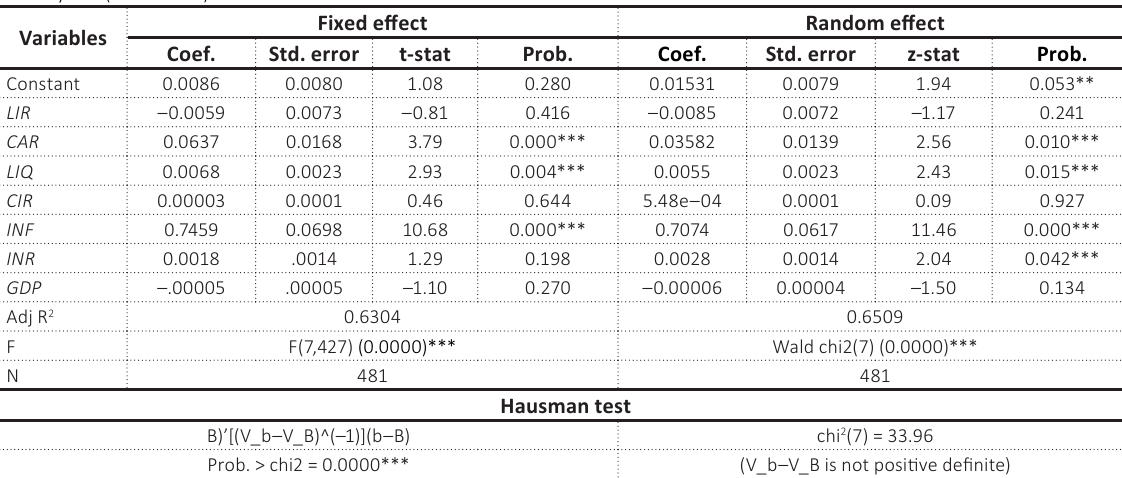
Table 5. General least square estimation NPL as a dependent variable Number of groups ( i ) = 47 listed commercial